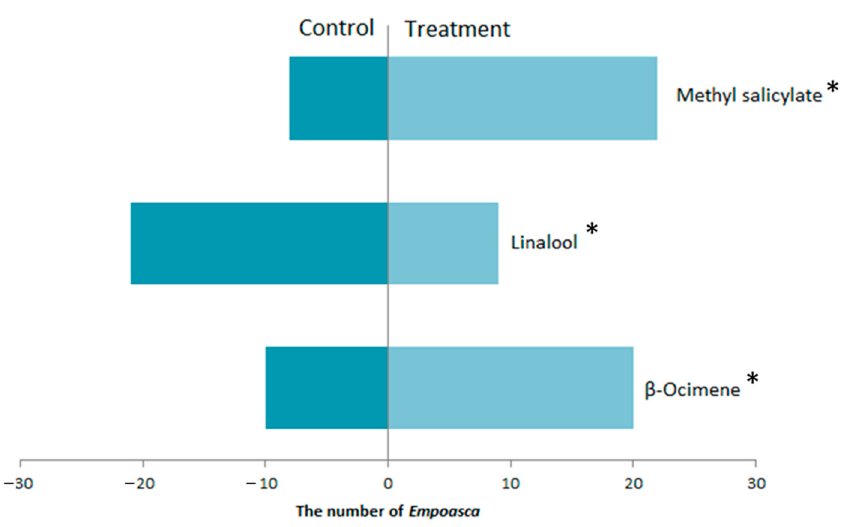
Figure 5. Bioassay results of E. flavescens to methyl salicylate, linalool, and β -ocimene. The insects either selected or avoided the region of a Y-tube olfactometer that contained the volatile compound. The asterisk indicates significant differences between groups (two-tailed binomial test).